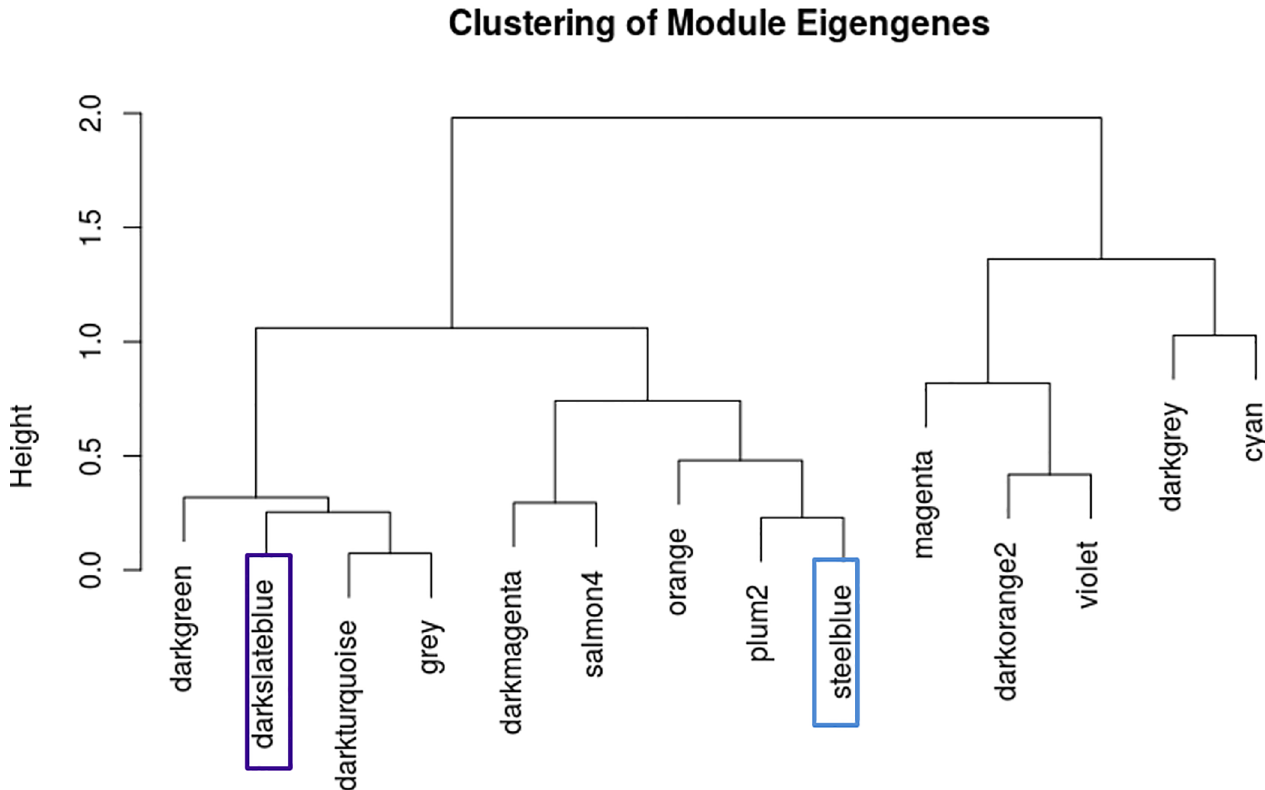
Fig 2. Statistical power and false discovery rate (FDR) for severalexpression